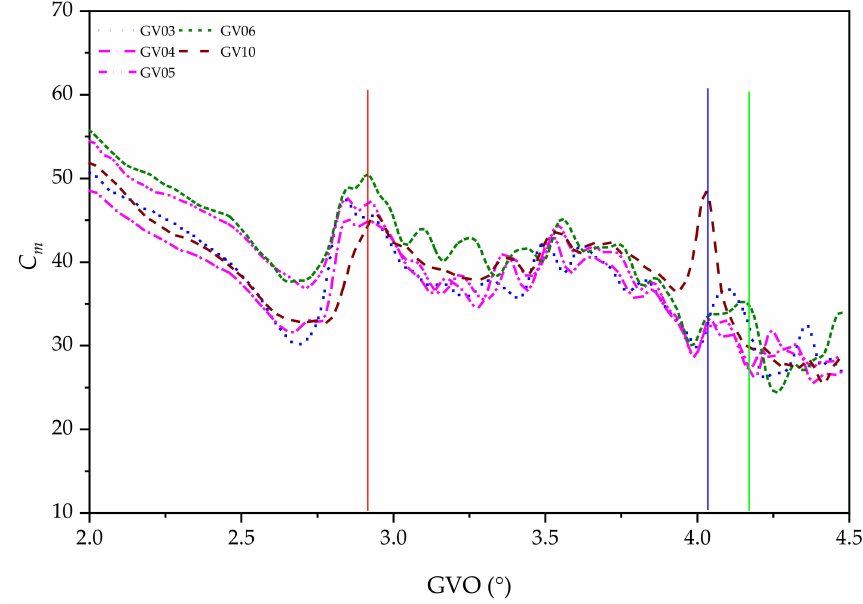
Figure 14. GVO- C m plot of the startup